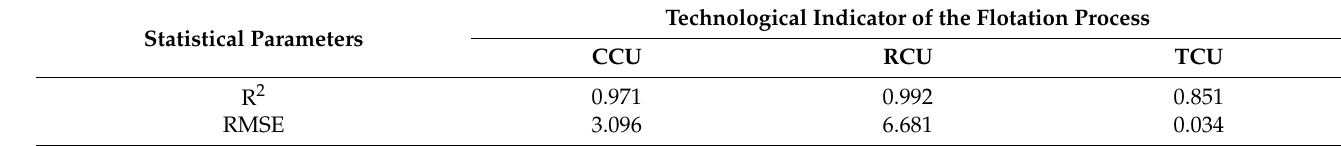
Table A1. Regression statistics parameters of PMM model training dataset.